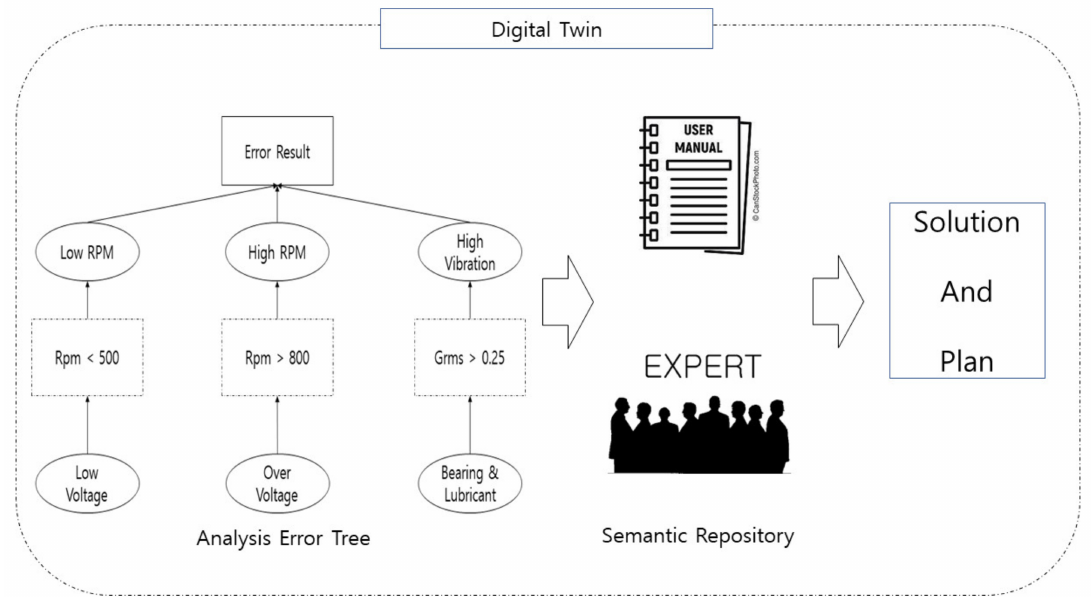
Figure 13. Goal models created by experts and manuals run on digital twins.